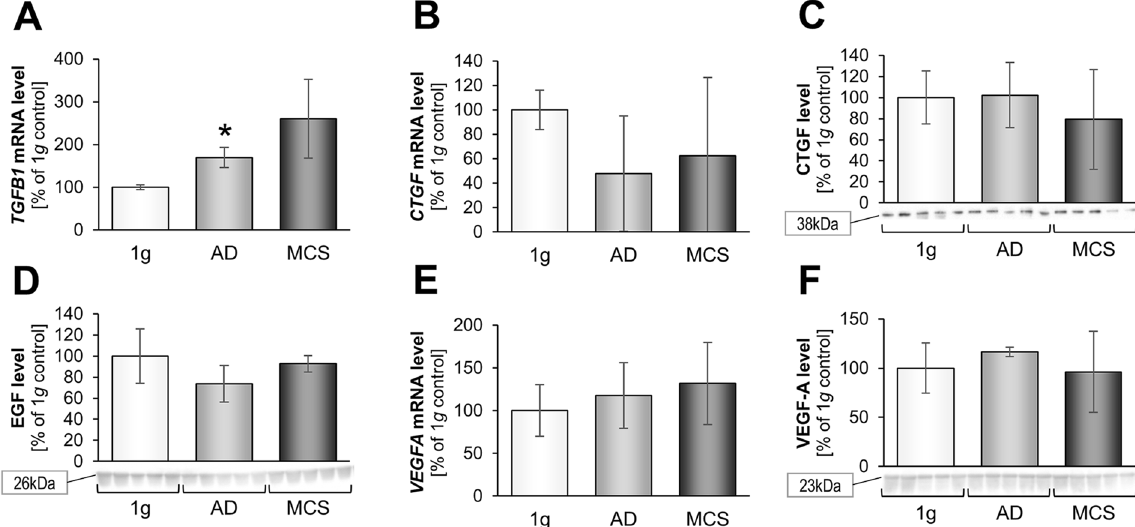
Figure 5. Investigation of selected growth factors after a 3-day s- µ g -exposure of normal human dermal fibroblasts: Quantitative gene expression levels of TGFB1 ( A ). Transcriptional and translational connective tissue growth factor (CTGF) analysis: Quantitative gene expression levels of CTGF ( B ) and intracellular CTGF protein levels ( C ). Intracellular EGF protein levels ( D ). Transcriptional and translational vascular endothelial growth factor A (VEGF-A) analysis: Quantitative gene expression levels of VEGFA ( E ) and intracellular VEGF-A protein levels ( F ). Full-length blots of cropped Western blot images are presented in Supplementary Fig. S4. * p < 0.05 1 g vs. RPM; # p < 0.05 AD vs.